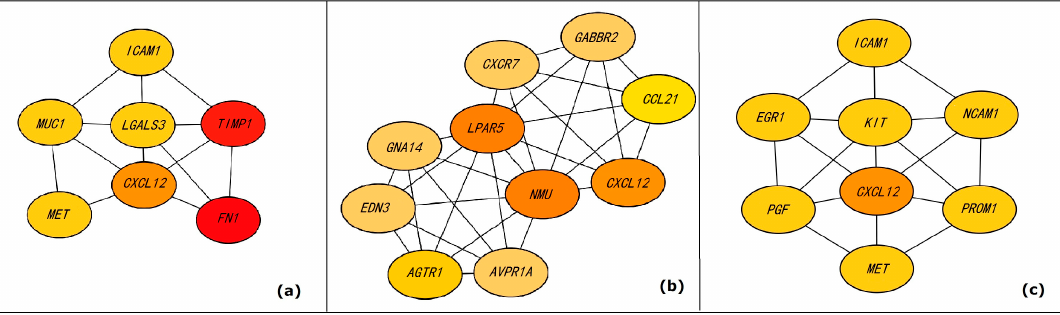
Figure 4. High-density subgraphs of DEGs interaction network. (a-c) show the high-density subgraphs